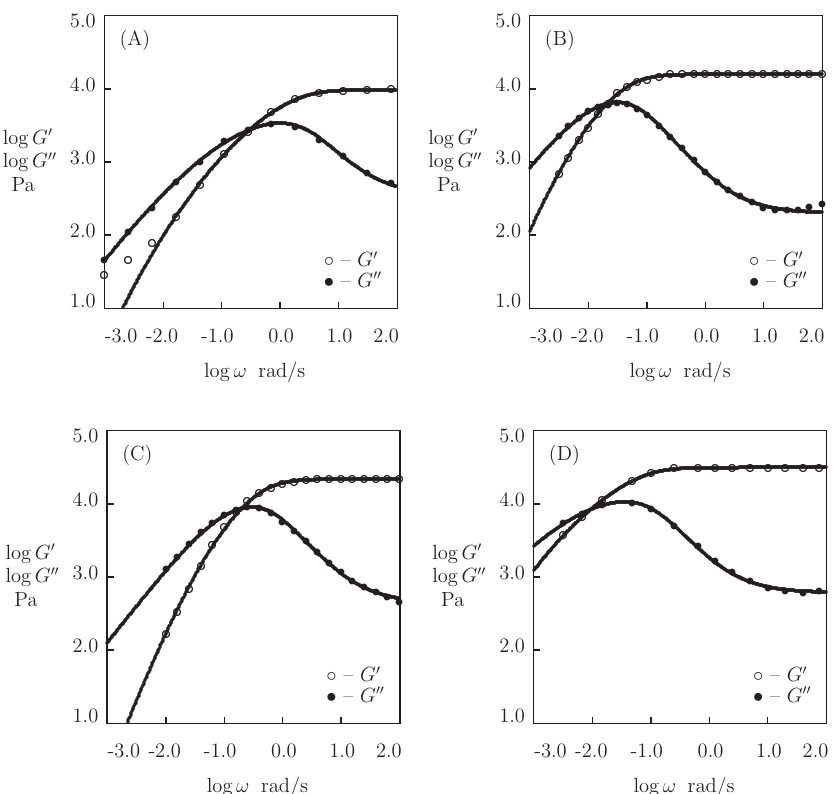
Figure 11. Storage modulus G (cid:48) and loss modulus G (cid:48)(cid:48) versus frequency ω . Symbols: experimental data on P 4 gels with various mass fractions of proteins proteins φ ( A )– φ = 0.15 [74], ( B )– φ = 0.22